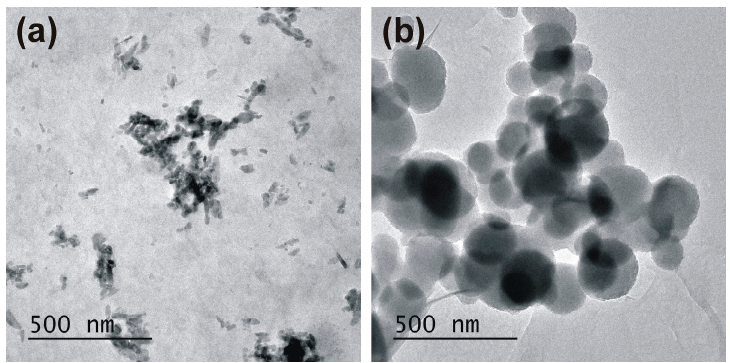
Figure 6. TEM images of ( a ) the octadecyl-modified silica particles witha 1:1 ODTES/sodium silicate molar ratio (Sample 2) and ( b ) the octadecyl-modified silica particles with an ODTES/sodium silicate molar ratio = 1:10 (Sample 5).